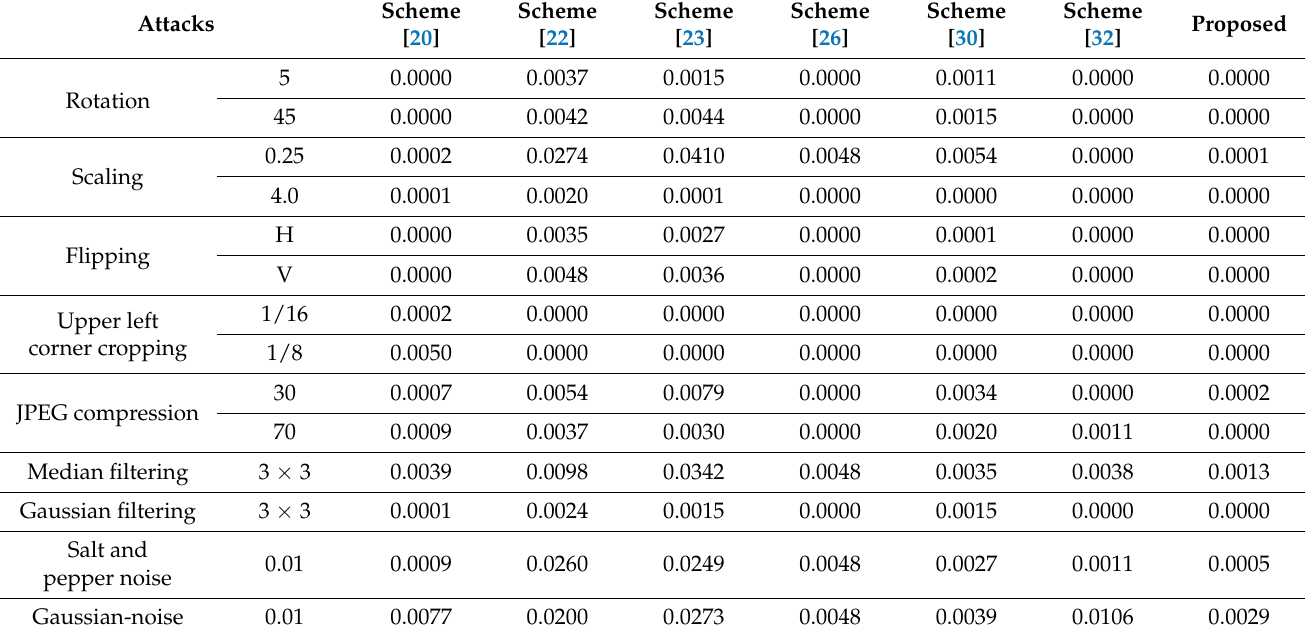
Table 5. Average BER comparison with [20,22,23,26,30,32].